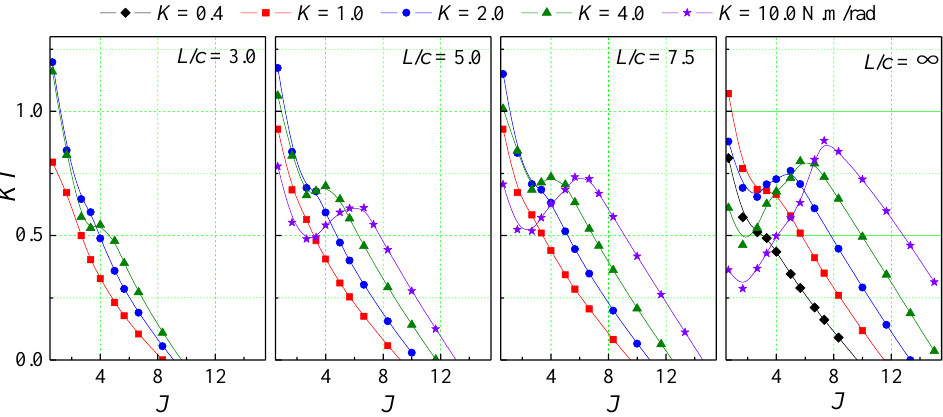
Figure 8. Thrust coefficient with different arm length ( 𝐿 ) and different spring stiffness ( K ).